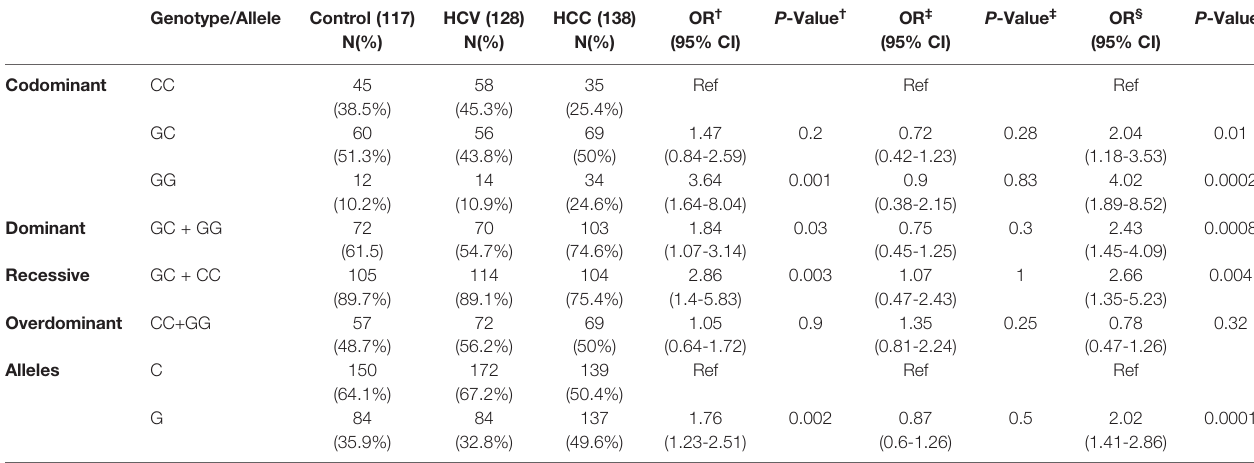
TABLE 4 | Genotype and allele frequency of EpCAM -935 C/G polymorphism in different study groups and its association to HCV and HCC risk by logistic regression analysis.